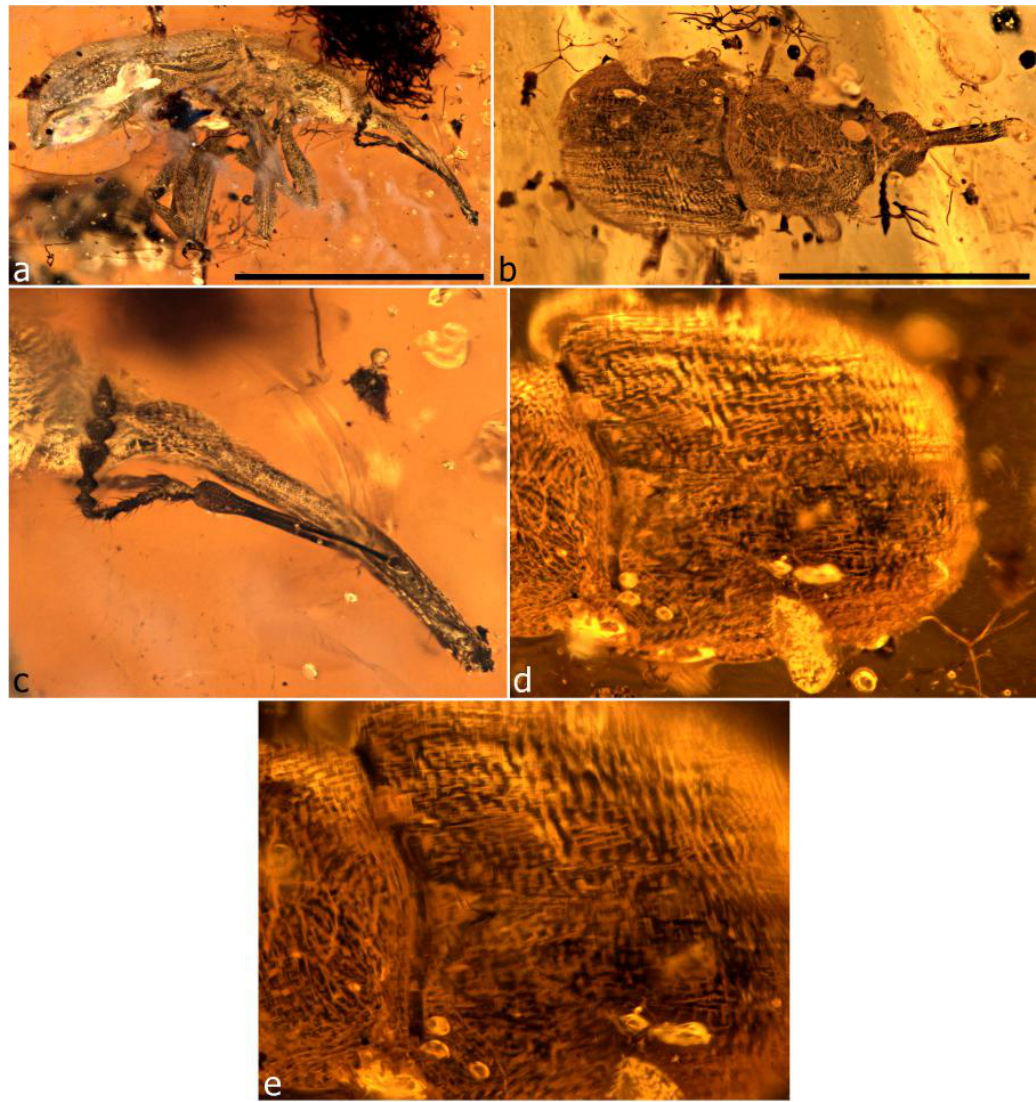
Figure 75. Periosocerus crenulatus sp. n., holotype. Habitus, right lateral ( a ); dorsal oblique ( b ); head and antenna, right lateral ( c ); elytra, dorsal oblique ( d ); same, detail ( e ). Scale bars: 1.0 mm (a,b). Genus Habropezus Poinar, Brown & Legalov, 2016 Habropezus Poinar, Brown & Legalov, 2016: 160 [54] (type species, by original designation: Redescription. Size. Length 1.74–3.0 mm, width 0.68–1.2 mm. Head short, subconical,